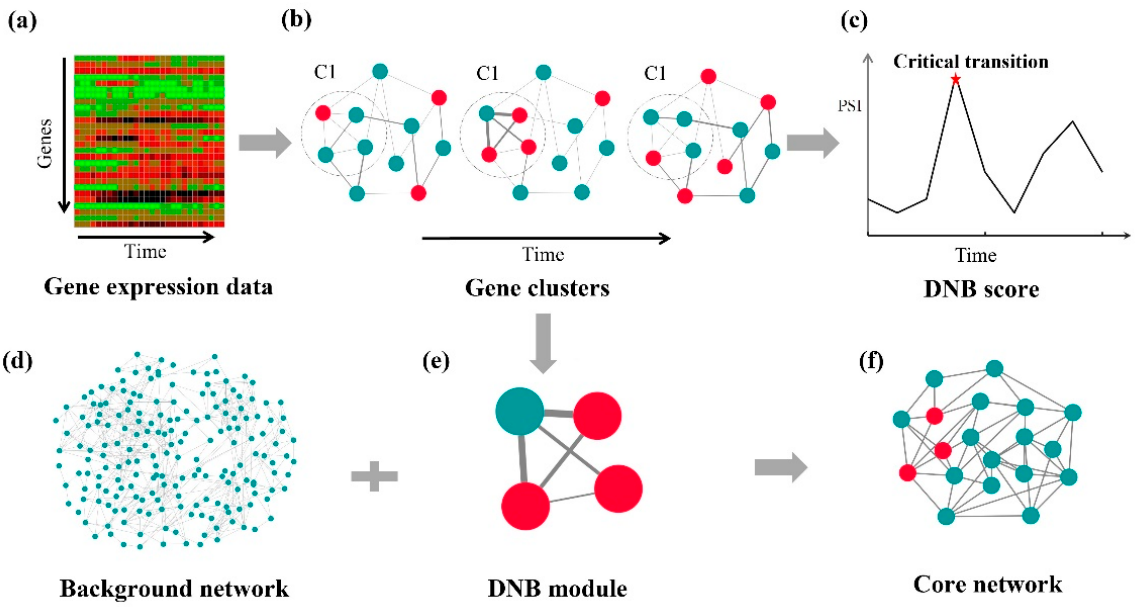
Figure 2. The flowchart of dynamic network analysis of grapevine fruit ripening.( a ) The time-series gene expression of grapevine fruit ripening. ( b ) For each time point, the genes were clustered into modules using the clustering algorithm and then the gene modules were used as a candidate DNB module for the regulator of phase transition of grapevine fruit ripening. ( c ) With these candidate gene modules, the PSI index was computed for each gene module in each sample. The module with the highest PSI index was collected for each sample and then these maximum PSI indices were used to detect the critical transition. ( d ) The background network of the PPIs from STRING. ( e ) The gene module with the maximum PSI index was taken as the DNB module. ( f ) The core network for grapevine fruit ripening was constructed with background network.